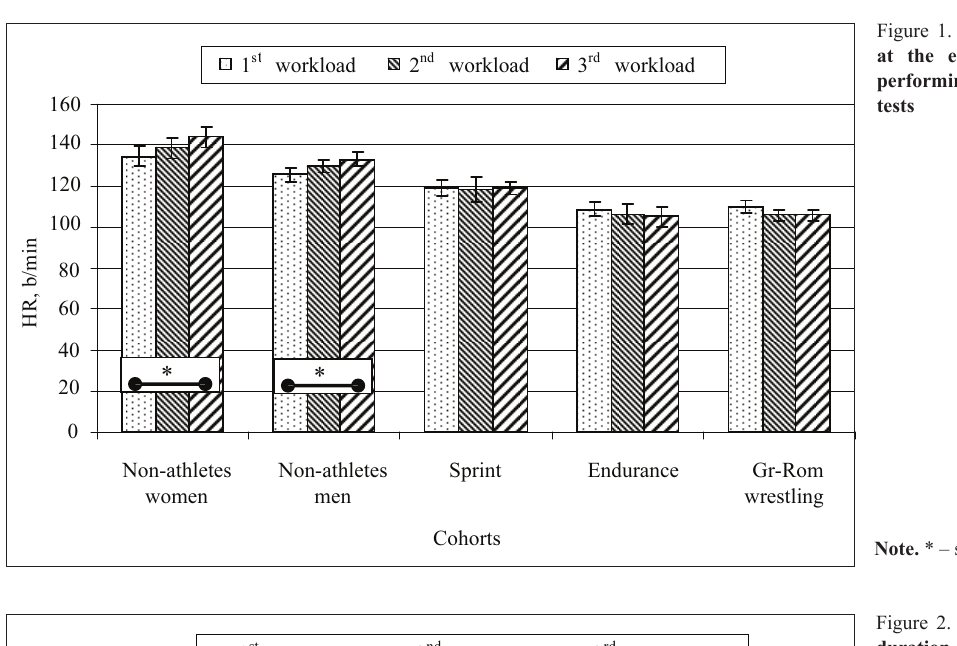
Figure 2. The registered shortest duration of JT interval while performing three Roufier exercise